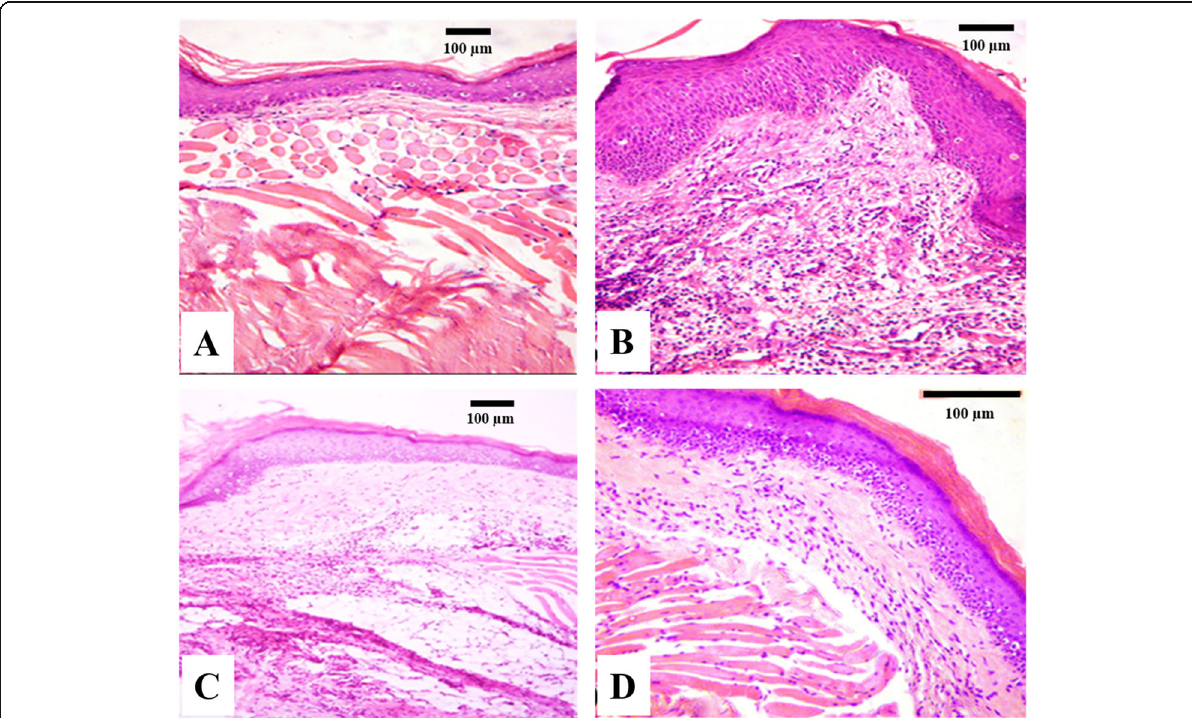
Fig. 3 Effect of the scorpion venom A. amoreuxi on mice inflamed foot paw tissues induced by carrageenan. a Normal control group: mice ( n = 6) were intraperitonially (IP) injected with 0.9% NaCl. One hour later, animals received intraplantar (IPL) injection of 50 μ L of 0.9% NaCl and scarified after 5 h from injection. Paw skin of control animal consists of three main layers: an external epithelium (epidermis), a layer of connective tissue (dermis), and a layer of adipose tissue (subcutaneous layer or hypodermis). There is also a thin layer of striated muscles separates the skin from other structures. b Carrageenan control group: mice ( n = 6) were IP injected with 0.9% NaCl. One hour later, animals received IP injection of 50 μ L of carrageenan (1%) and scarified after 5 h from injection. Animal paw skin shows the dermis was markedly infiltrated with inflammatory cells, neutrophils, macrophages, and some lymphocytes. Some areas showed loosely arranged connective tissue (edema). c A. amoreuxi venom-treated group: mice ( n = 6) were IP injected with 0.22 mg/kg (1/5 LD 50 ) of scorpion venom. One hour later, animals received IPL injection of 50 μ L of carrageenan and scarified 5 h post-injection. Paw skin of treated animals was moderately infiltrated with inflammatory cells like neutrophils, macrophages, and some lymphocytes. d Diclofenac-treated group: mice ( n = 6) were IP injected with 1 mg/kg of diclofenac sodium. One hour later, animals received injection of 50 μ L (IPL injection) of carrageenan and scarified 5 h post-injection. The dermis of animals received diclofenac was characterized by minimum infiltration with some neutrophils, and lymphocytes. (H&E, magnification ×